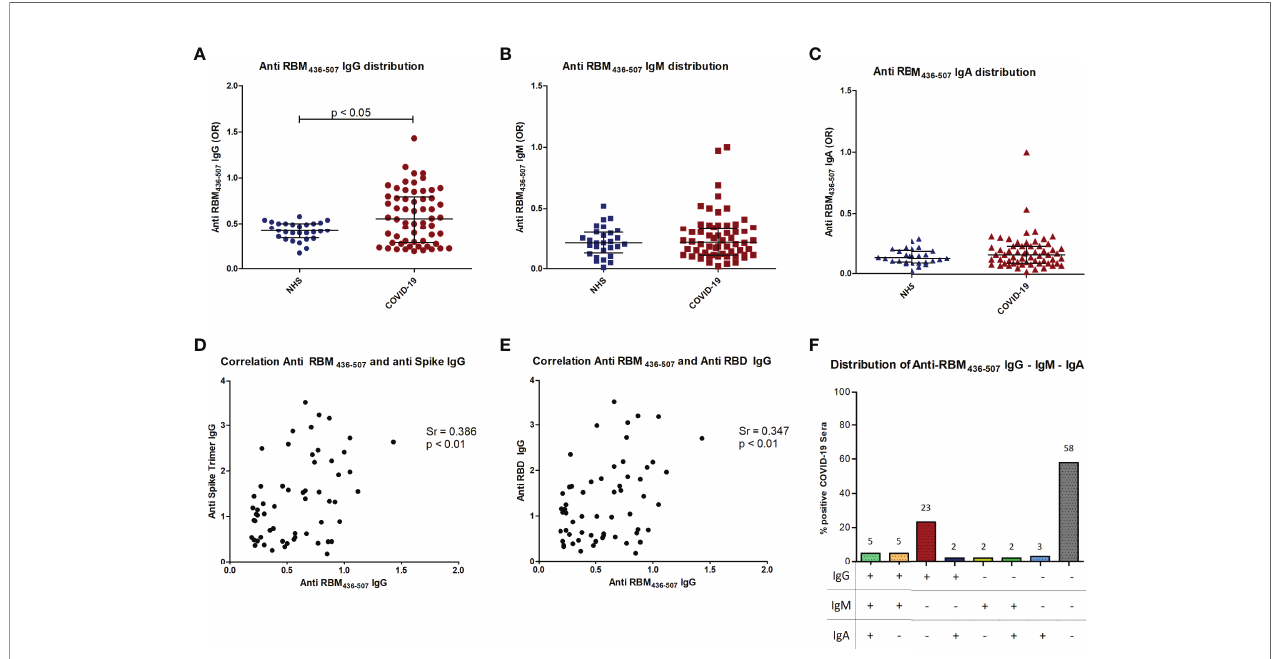
FIGURE 6 | Anti-RBM 436-507 Ig isotypes in COVID-19 patients. Distribution of anti RBM IgG (A) , IgM (B) and IgA (C) in COVID-19 patients is shown compared to normal controls (NHS). Correlation of anti-RBM IgG with anti-Spike (D) or anti-RBD (E) IgG in COVID-19 patients (D) . Distribution of anti-RBM antibody isotypes (F) . p < 0.05 was considered signi fi